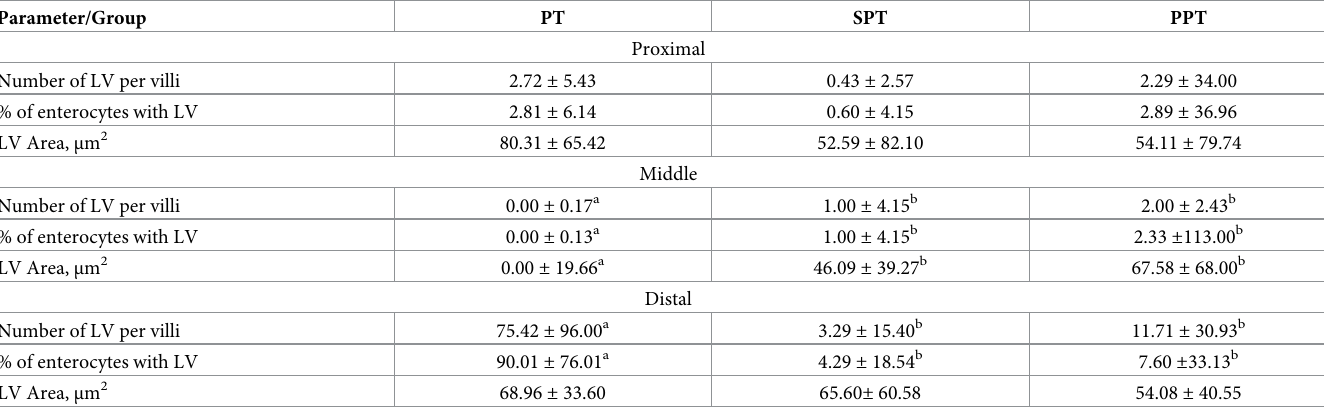
Preterm piglets without treatment—PT, preterm piglets fed infant formula—SPT, and preterm piglets fed pre-hydrolyzed infant formula—PPT, LV—lysosomal vacuoles. Values are given as Median ± IQR. a,b,c Values within a row with different superscript letters differ significantly at p < 0.05. Data was assessed using a Kruskal-Wallis test followed by a Dunn’s multiple comparison